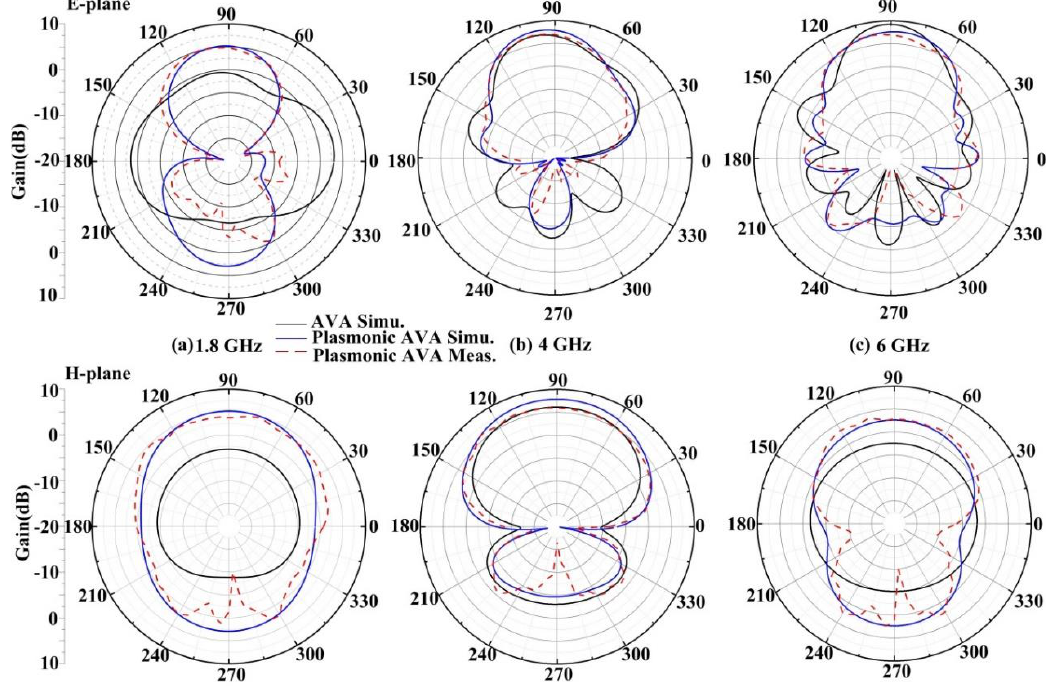
Figure 8. Simulated and Measured radiation patterns of the plasmonic AVA at ( a ) 1.8 GHz, ( b ) 4 GHz, and ( c ) 6 GHz. Table 1. Simulated half-power bandwidth (HPBW) of the AVA and plasmonic AVA. Frequency Typical